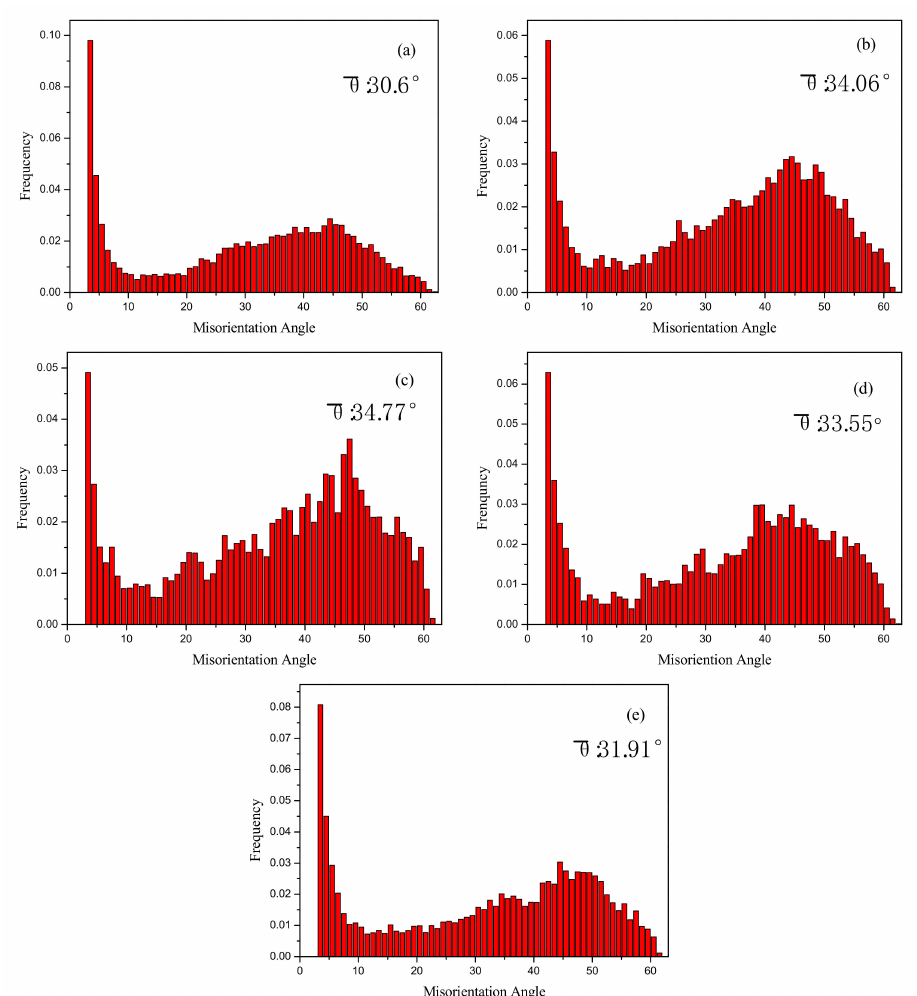
Figure 10. Distributions of misorientation angles of 7085 and TiC / 7085 after T6 treatment ( a ) 7085; ( b ) 0.1 wt% TiC / 7085; ( c ) 0.3 wt% TiC / 7085; ( d ) 0.5 wt% TiC / 7085; ( e ) 1 wt% TiC /